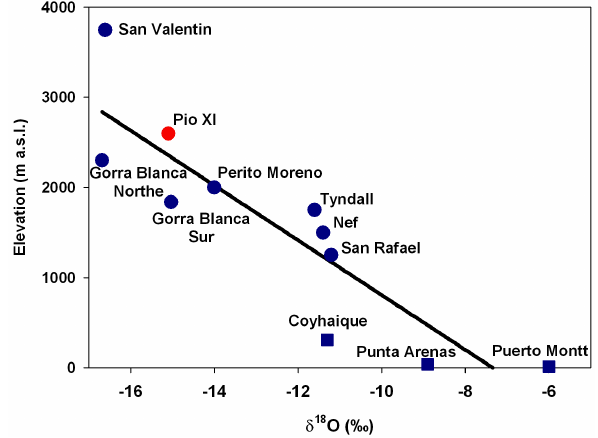
Fig. 9. Mean δ 18 O values as function of elevation compared for different ice cores from SPI and NPI (circles) and nearest GNIP stations (squares). Ice core data from San Valentín, Gorra Blanca, Perito Moreno, Tyndall, Nef, and San Rafael are from (Aristarain and Delmas, 1993, Matsuoka and Naruse, 1999, Schwikowski et al., 2007, Shiraiwa et al., 2002, Vimeux et al., 2008, Yamada, 1987).